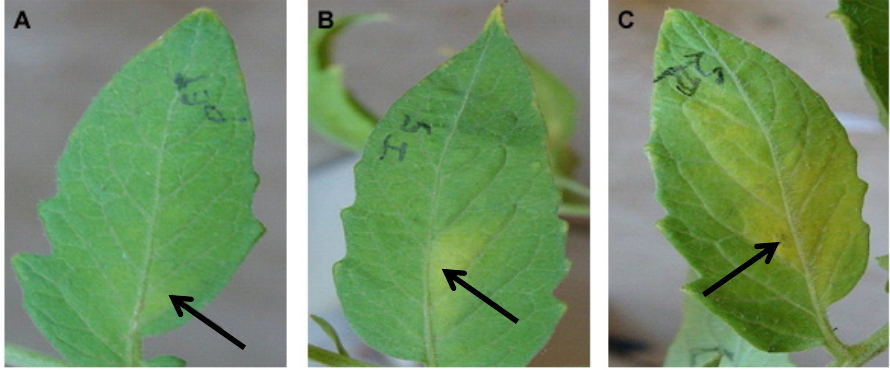
Figure 2. In Planta transient assay with bacterially expressed BcSnod proteins. A. Tomato leaves injected with empty vector control showed minimal discoloration. B and C. Leaves injected with 200 μ g of bacterial produced, renatured BcSnod1 and BcSnod2, respectively. Signs of discoloration were readily apparent after 3 days, even more pronounced at 5 dpi (shown here). Arrows designate site of injection.